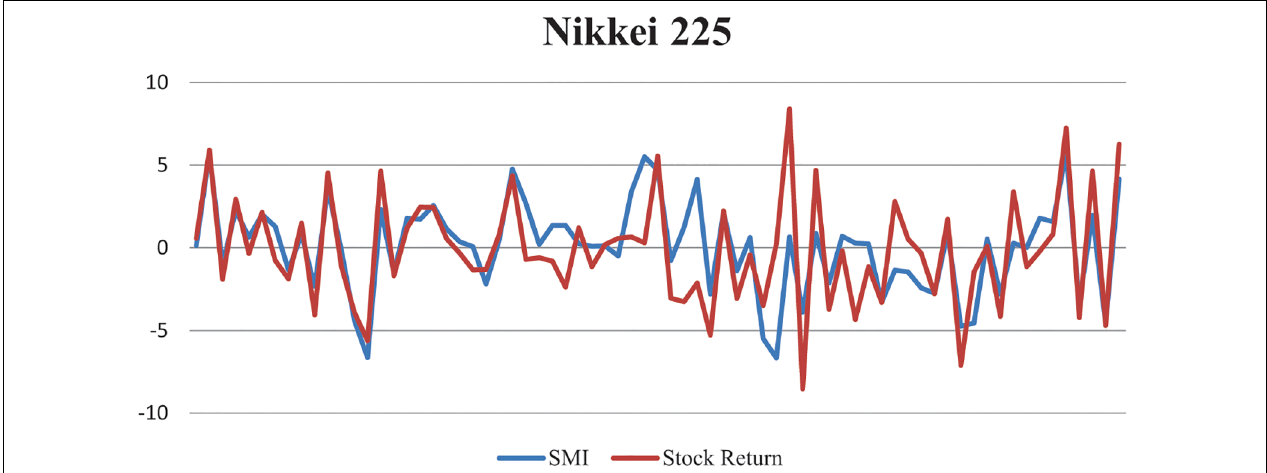
FIGURE 3 | Relationship between Nikkei 225 market returns and created Sentiment Index.